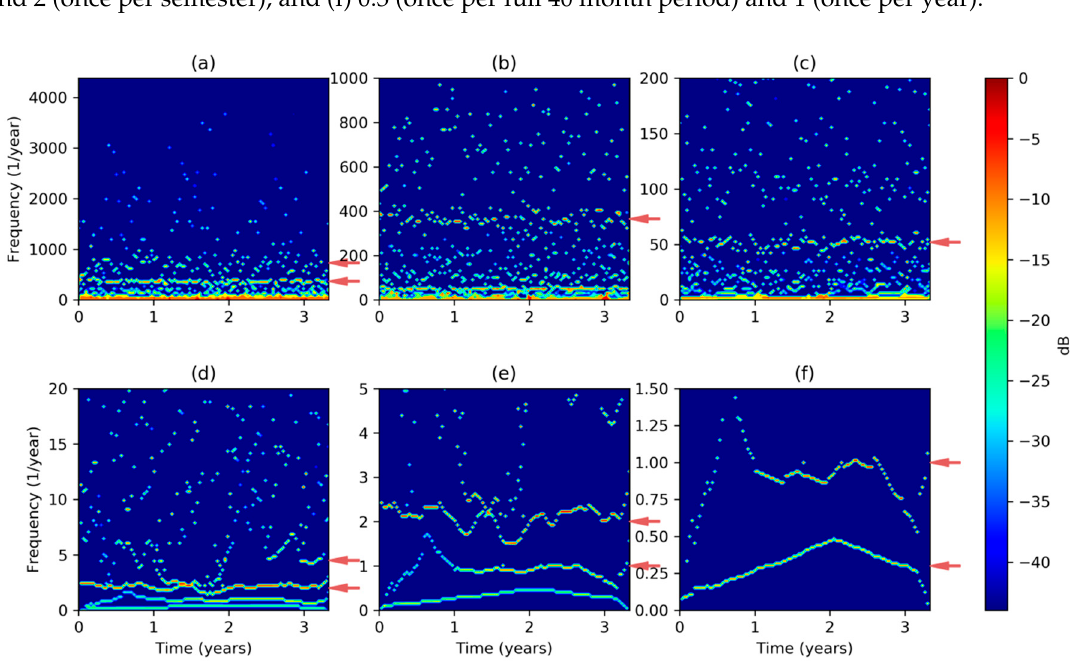
Figure 13. Electricity demand Marginal Hilbert–Huang Spectrum at different frequency scales: ( a ) High; ( b ) medium; ( c ) low. In red are the harmonics obtained by Fourier analysis, while in green are the new harmonics revealed by HHT. It has to be noted that although DHHS and its derived MHHS are quantized in frequency (also in time), the frequency step Δ𝑓 can be arbitrary selected. To maintain the details at each frequency scale, the number of frequency quanta has been fixed to 100 in every panel of Figure 13 (also in Figure 12). On the other hand, frequency resolution in FT is fixed and depends on the number of values in the dataset ( Δ𝑓 = 0.3 in our case). Then FT leads to an over-detailed spectra for full range frequencies (Figure 2a), and to an under-detailed spectra for small range frequencies (Figure 2c).